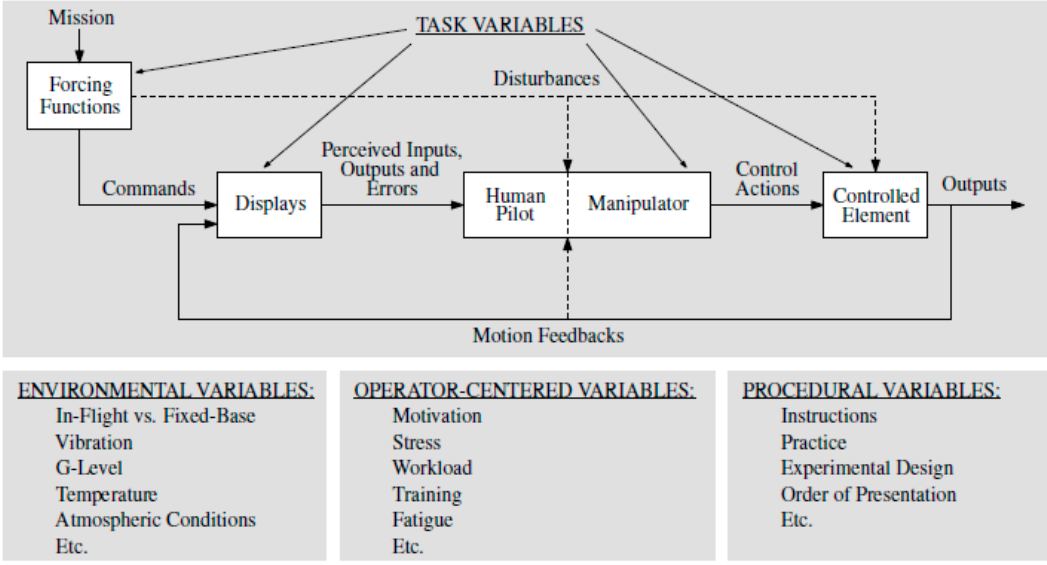
Figure 1. Single-loop compensatory tracking tasks (based on Reference [1]).